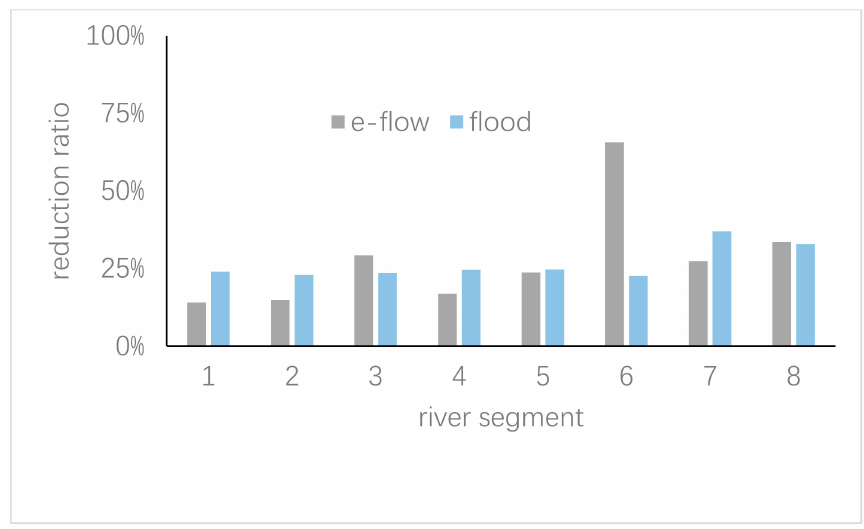
Figure 3. Comparison of reduction ratios between e-flow requirement and flood control ability under the high hydrological connectivity scenario (specific flow velocity = 0.2 m / s) with a siltation depth equal to 0.5 m.